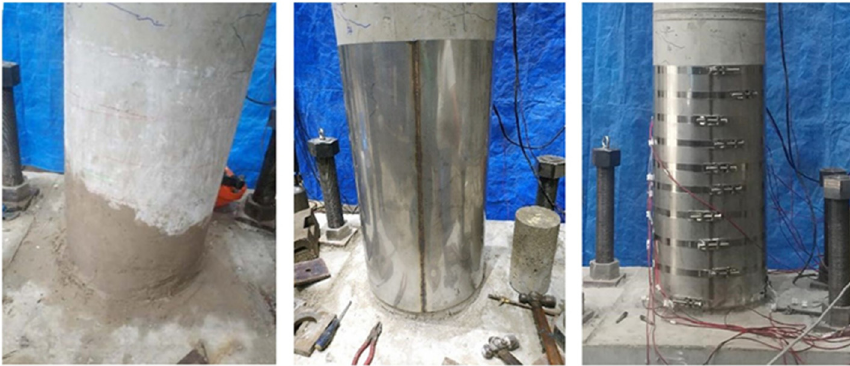
Figure 15. Steel jacketing strengthening process. Adapted from [144].